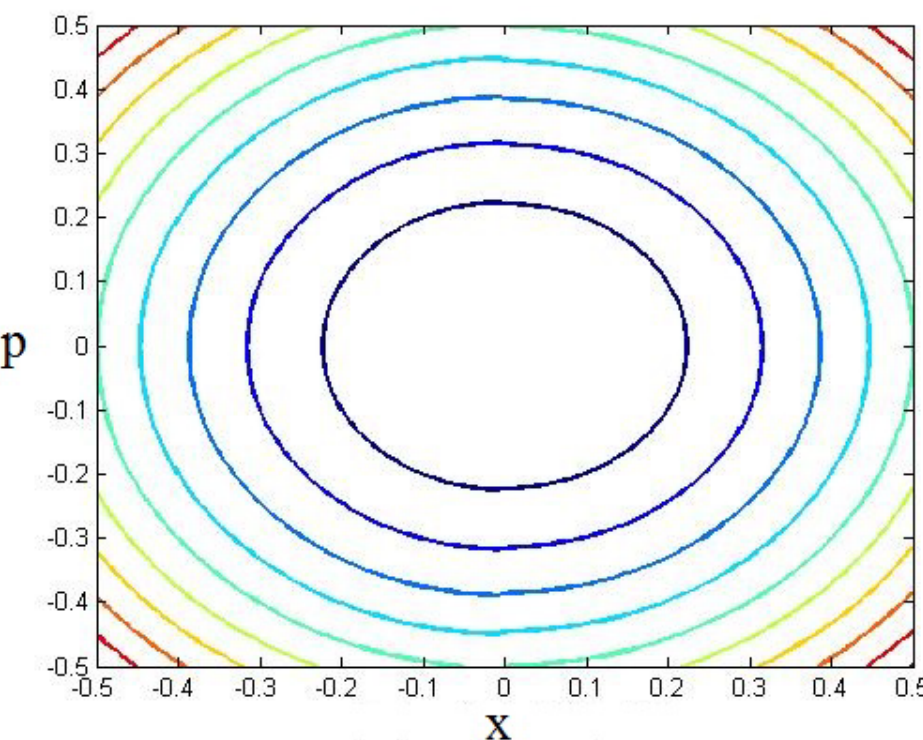
Figure 4. Phase portrait of the PDM Hamiltonian associated with single well potential for λ = 0.01.